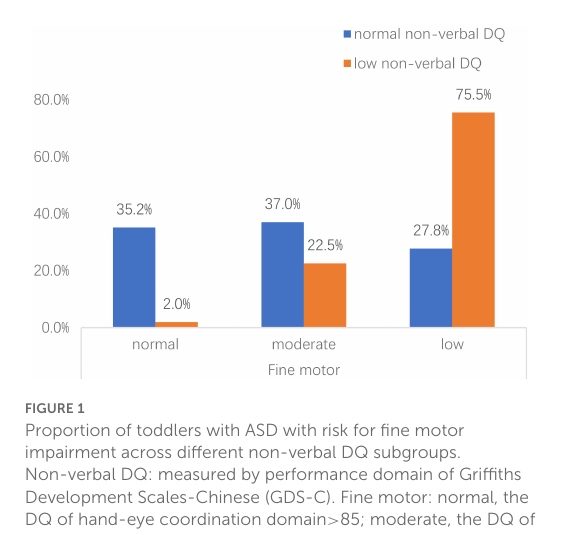
FIGURE1 Proportion of toddlers with ASD with risk for fine motor impairment across different non-verbal DQ subgroups. Non-verbal DQ: measured by performance domain of Griffiths Development Scales-Chinese (GDS-C). Fine motor: normal, the DQ of hand-eye coordination domain > 85; moderate, the DQ of hand-eye coordination domain ranges 70–85; low, the DQ of hand-eye coordination domain < 70.